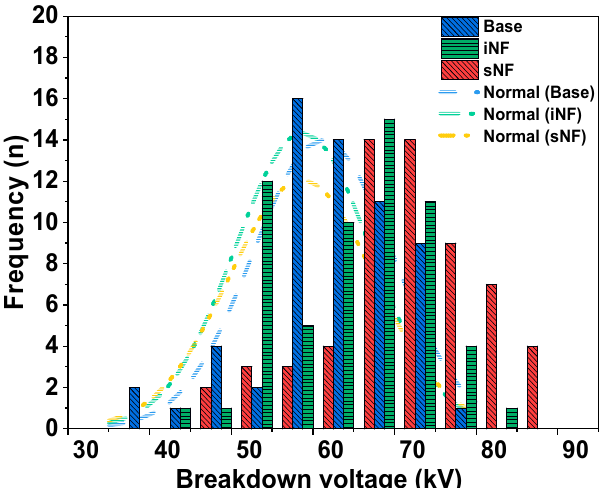
Figure 6. Frequency density plots of the breakdown events for each sample in question with conformity to Normal distribution. Table 5. Breakdown Voltages at 1, 10 and 50% probability levels for normal and Weibull distributions.